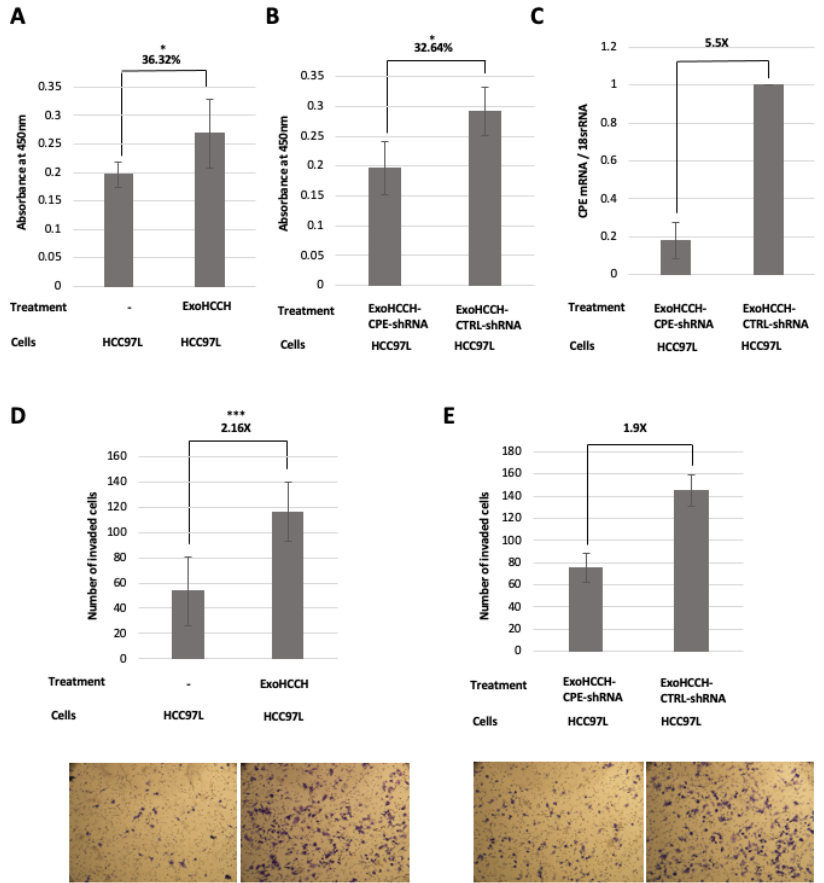
Figure 4. Exosomes from HCC97H cells enhance proliferation and invasion of recipient HCC97L cells in a CPE-dependent manner. ( A , B ) Bar graph showing the absorbance values obtained in the MTT cell proliferation assay on day 5 of HCC97L cells treated with exosomes (corresponding to 75 µ g of exosomal protein) from HCC97H cells (ExoHCCH, A ) or with exosomes isolated 48 h after lipofectamine- mediated transfection of HCC97H cells with either 25 nM of CPE targeting shRNA or control shRNA, (ExoHCCH-CPE-shRNA/ExoHCCH-CTRL-shRNA, B ) (N = 2, n = 3). ExoHCCH increase the proliferation of HCC97L cells, however downregulation of CPE expression in HCC97H cells before exosome isolation abolishes this effect. Data represents mean ± SD of 2 independent experiments. ( C ) Bar graph showing the fold change in knockdown of CPE mRNA levels in HCC97L cells treated with ExoHCCH-CPE-shRNA relative to cells treated with ExoHCCH-CTRL-shRNA (N = 2). Data represents mean ± SD of 2 independent experiments. The 2 − ∆∆ Ct method was used for gene expression analysis and 18s rRNA was the internal control. ( D , E ) Bar graph and representative images of wells showing the number of HCC97L cells that invaded through matrigel after treatment with ExoHCCH ( D ) (N = 2, n = 2), or with either ExoHCCH-CPE-shRNA or ExoHCCH-CTRL-shRNA ( E ) (N = 1, n = 2). Data represents mean ± SD of 2 independent experiments ( D ) and mean ± SD of technical replicates ( E ). HCCH97L cells treated with ExoHCCH exhibit enhanced invasion through matrigel, and this effect is abolished if HCC97H cells are transfected with CPE-shRNA before exosome isolation. Scale bar = 100 µ m. Statistical analysis for all panels was performed by Student’s t -test: *, p < 0.05; ***, p <